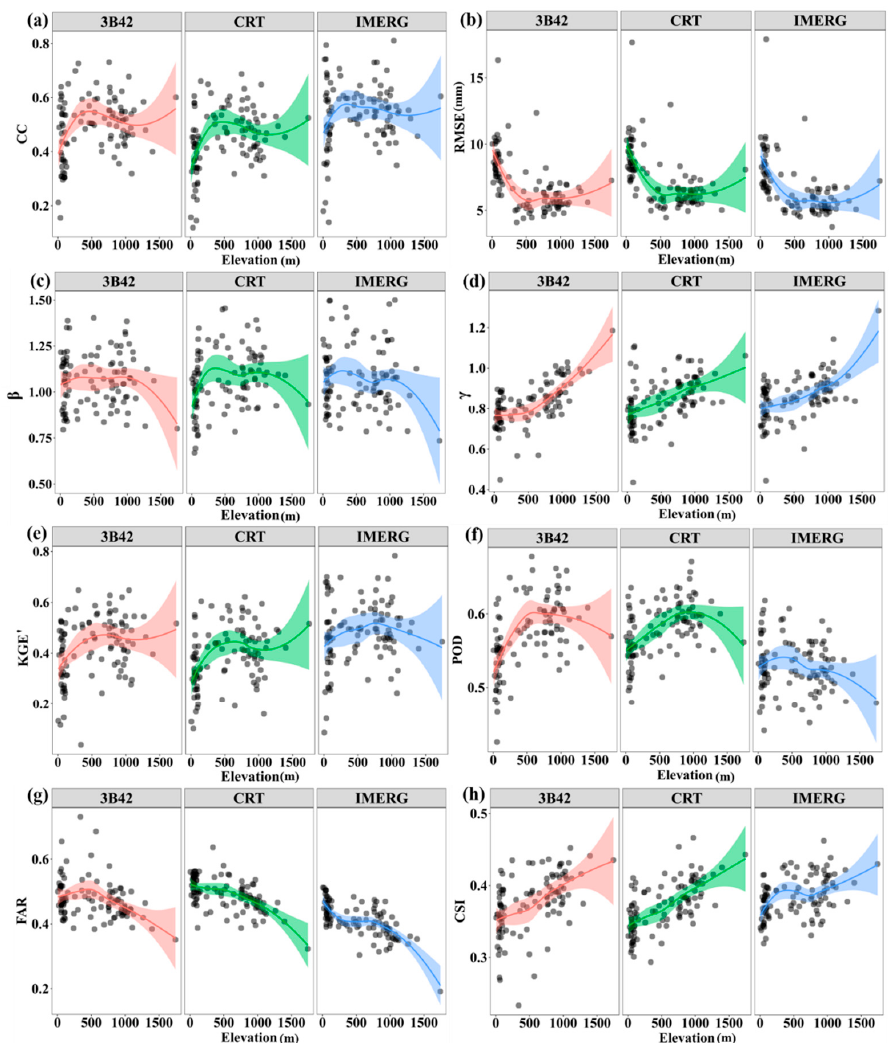
Figure 4. Relationship between evaluation metrics and elevation for 3B42, CRT and IMERG based on locally weighted regression model. Figure ( a–h ) stands for the metrics of CC, RMSE, β , γ , KGE’, POD, FAR and CSI, respectively.